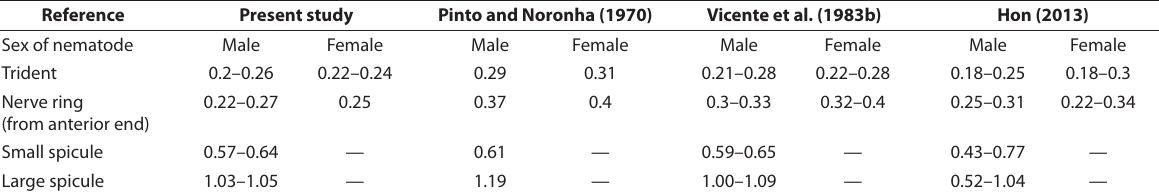
Table 1. Comparison of the morphological traits (mm) of Diplotriaena delirae Pinto & Noronha, 1970 from various studies.